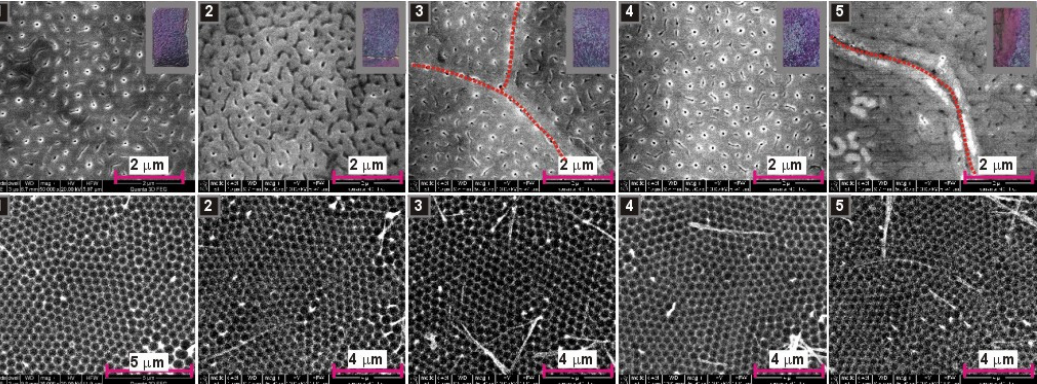
Figure 7. SEM images of AAO—top view (upper row) and nanoconcaves left on aluminum surface after AAO dissolution (lower row) for the samples anodized for 7 h, at 5 °C, 300 V, five times in a row in the same 0.25 M malic acid solution; in the right corners of the SEM images presented in the upper row, photographs of the samples after anodization are shown (in grey frames).